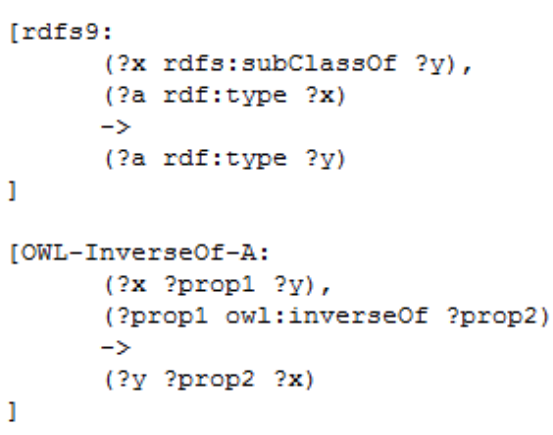
Figure 4. An example of the implemented semantic rules. The first rule is extracted from the RDF Model Theory and models the transitivity of the subClassOf relationship. The second rule is extracted from the OWL Model Theory and models the behavior of the inverse properties.